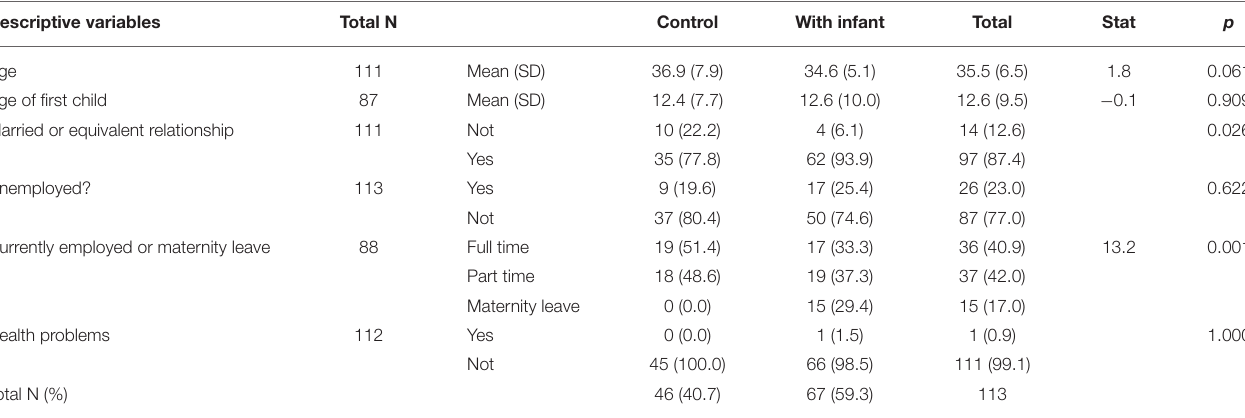
TABLE 1 | Description of the samples of women taking part in the study who did not have a baby of under 24 months old in their care when the study was carried out (Control) and of those who did (With Infants). Descriptive variables